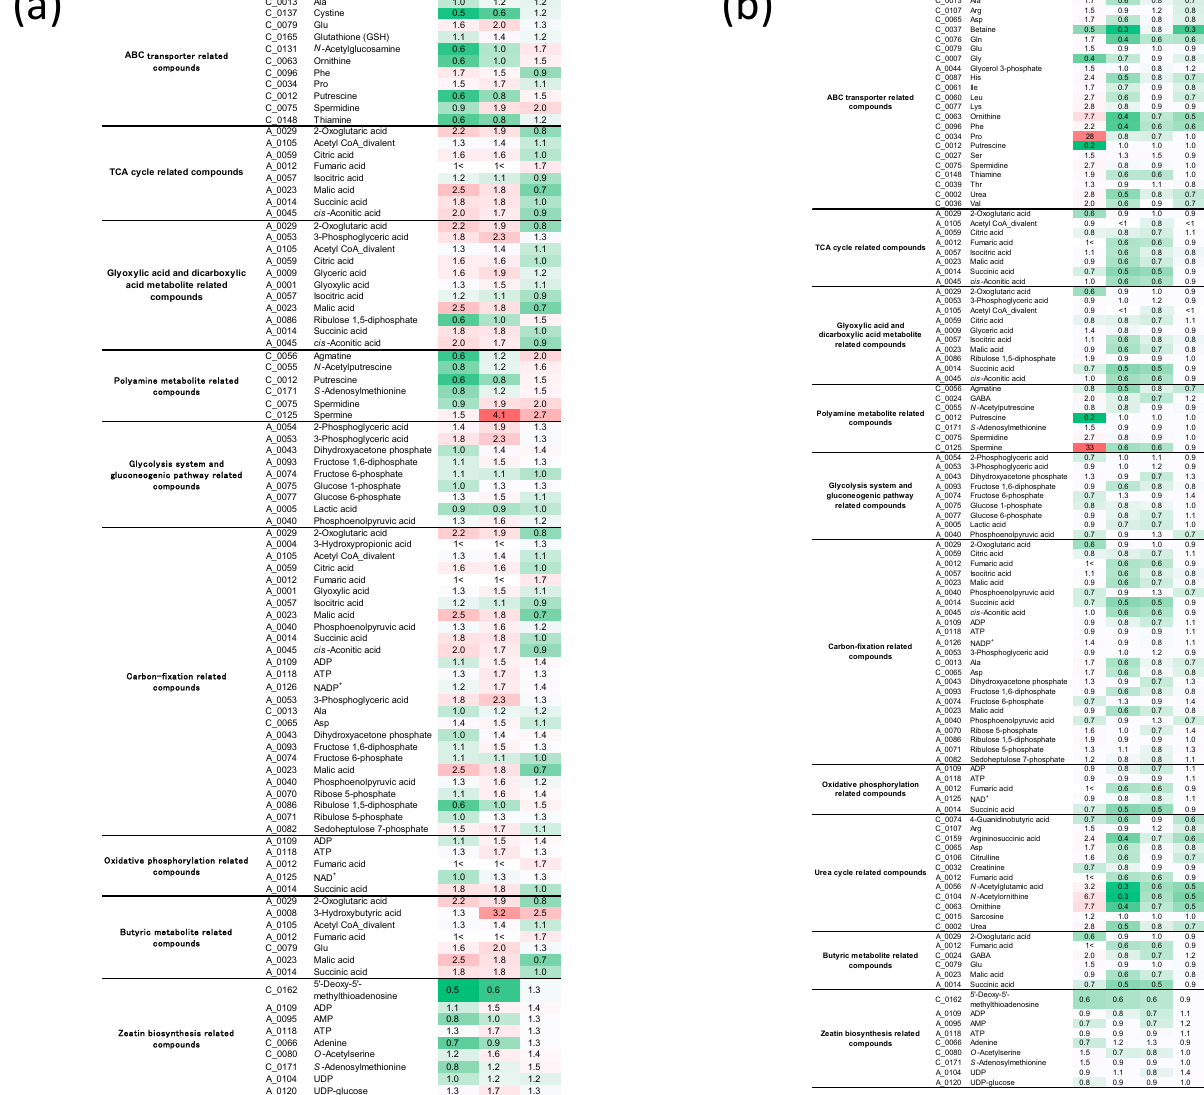
Figure 7. Heatmap of major metabolite groups based on comparative ratio in plants inoculated with strain 4 or strain 2 compared with mock-inoculated plants ( a ); and in plants inoculated with strain 4 or strain 2 compared with mock-inoculated plants under saline conditions ( b ). Green (low) to red (high) represents the increase in relative area of each peak among the three treatments.